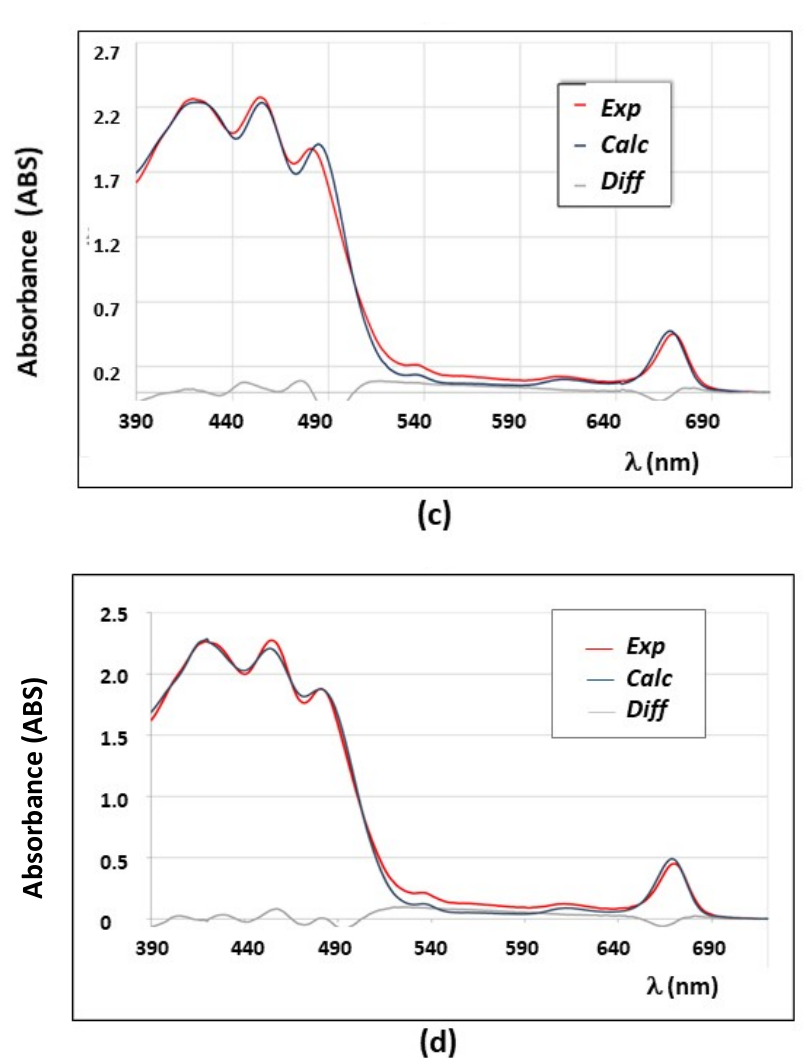
Figure 7. Experimental (Exp) and calculated (Calc) UV-vis absorption spectra of fresh EVOO samples. Residues are also show in the plot (Diff). Spectra are here reported with an optical path of 1.0 cm. ( a ) Sample E (after 35 days from oil production); ( b ) sample E (after 95 days from oil production); ( c ) sample F (after 40 days from oil production); ( d ) sample B (after 38 days from oil production). Data analysis was performed through the new deconvolution model, as described in the text.